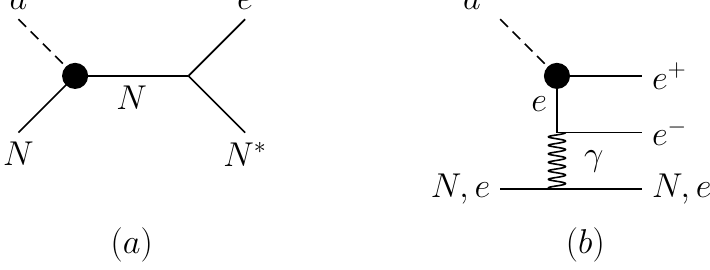
= γ, e, n , where n refers to aXX , X